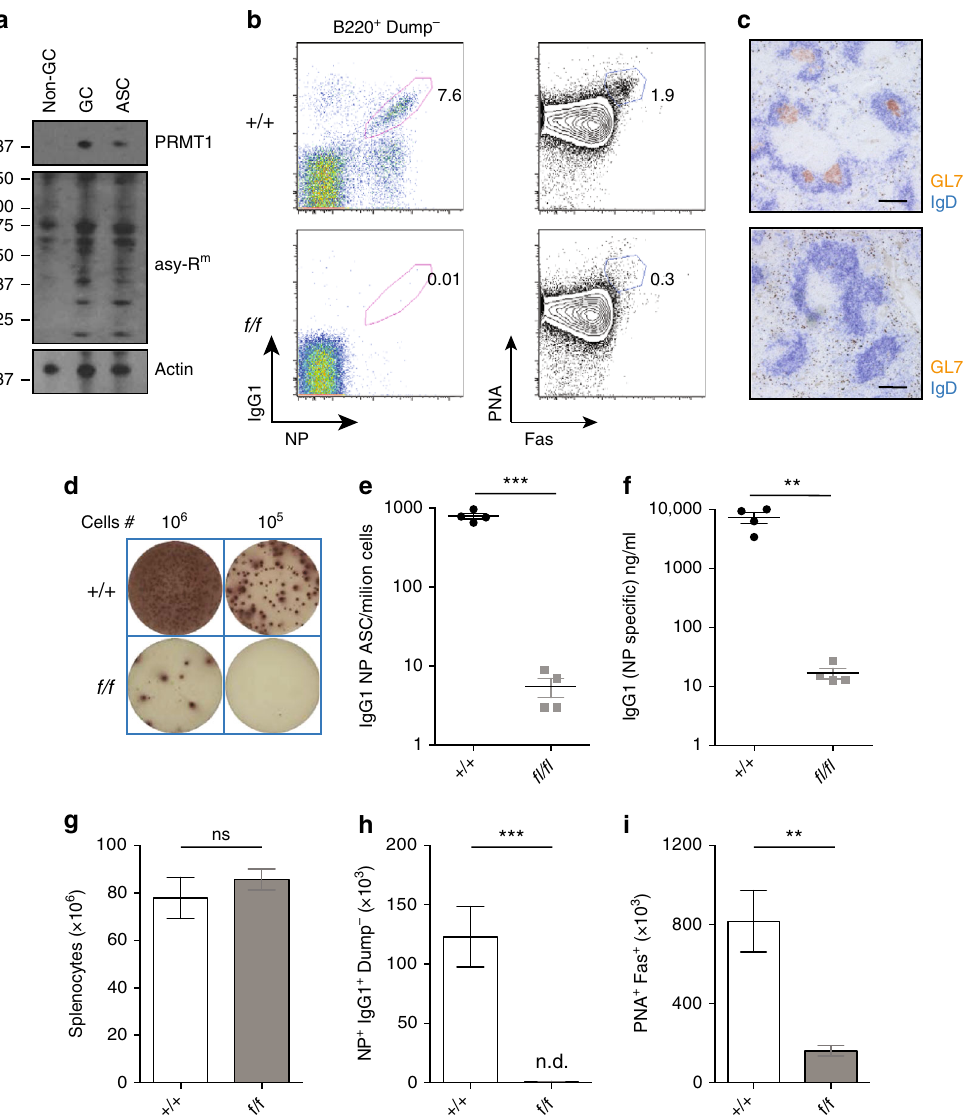
Fig. 4 PRMT1 is required for GC formation in response to immunization. a Control mice were immunized with NP-KLH in alum and the indicated B-cell subsets were sorted from spleen 7 days post immunization, lysed and proteins separated by SDS-PAGE. Western blot analysis shows PRMT1 (top panel), asymmetrically methylated arginine-containing proteins (middle panel) and actin (loading control, bottom panel) in non-GC B cells (CD19 + Fas - PNA − ), GC B cells (CD19 + Fas + PNA + ) and ASC (CD138 + B220 low ). b – i Control ( + / + ) and Prmt1 f/f CD23Cre ( f/f ) mice were immunized with NP-KLH in alum and analyzed at day 7. b NP-speci fi c IgG1 + B cells (left) and total GC B cells (right) are shown in representative fl ow cytometry plots. Numbers indicate frequency of indicated events within the B220 + Dump − . Dump antibodies detected IgM; IgD; Gr1. c Immunohistochemical staining for GC in spleen sections at day 7 post NP-KLH immunization using GL7 (orange) and IgD (blue) with scale bars indicating 100 μ m. Representative wells d and frequency per million splenocytes e of NP-speci fi c IgG1 + ASC as measured by ELISpot at day 7 post immunization. f Serum titres of NP-speci fi c IgG1 antibody as determined by ELISA at day 7. Total splenocyte number g , number of NP-reactive IgG1 + B cells h and GC B cells (PNA + Fas + ) i , calculated at day 7 post immunization of control (+/+) and Prmt1 f/f CD23Cre ( f/f ) mice as indicated. ** P ≤ 0.01, *** P ≤ 0.001; ns = not signi fi cant (unpaired t -test). Data are representative of three independent experiments with four mice per group. Mean and s.e.m. in e – i . Uncropped images of blots are presented in Supplementary Fig. 5. Flow cytometry gating strategies for this fi gure are shown in Supplementary Fig. PRMT1 is required in B cells for humoral immunity . The revealed that the basal oxygen-consumption rate (OCR) in unstimulated B cells was not in fl uenced by Prmt1 de fi ciency (Supplementary Fig. 2a) but conversely, PRMT1 was required for basal and maximal respiratory capacity as well as glycolytic capacity in activated B cells (Supplementary Fig. 2a – c). Thus, PRMT1 activity was required for normal B-cell responses to stimuli that mimic aspects of T-cell dependent (TD) or T-cell independent (TI) responses and this included the metabolic reprogramming that follows activation. arginines (Fig. 4a). The amount of PRMT1 was low in non-GC